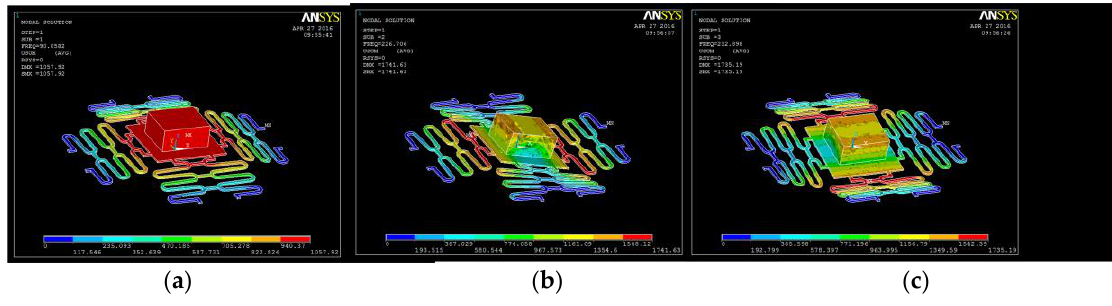
Figure 7. The simulation of the mode shape of the microspring with the permanent magnet. ( a ) The First mode; ( b ) The second mode; ( c ) The third mode.